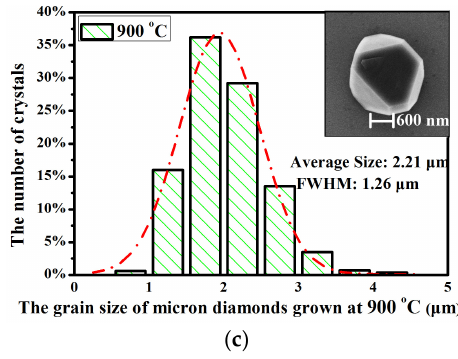
Figure 4. The grain size distribution of CVD microcrystalline diamonds at the substrate temperatures of ( a ) 700 °C, ( b ) 800 °C, and ( c ) 900 °C, and their FESEM micrographs under the identical conditions.